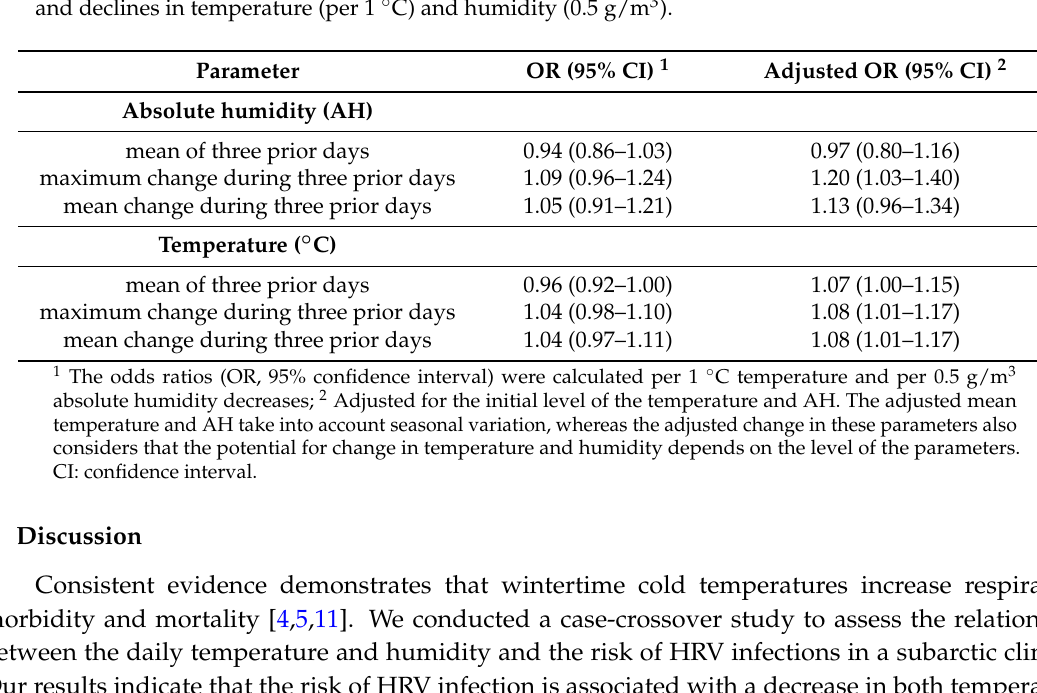
Table 2. Onset of a human rhinovirus (HRV) infection ( n = 146) and its association with mean values and declines in temperature (per 1 ◦ C) and humidity (0.5 g/m 3